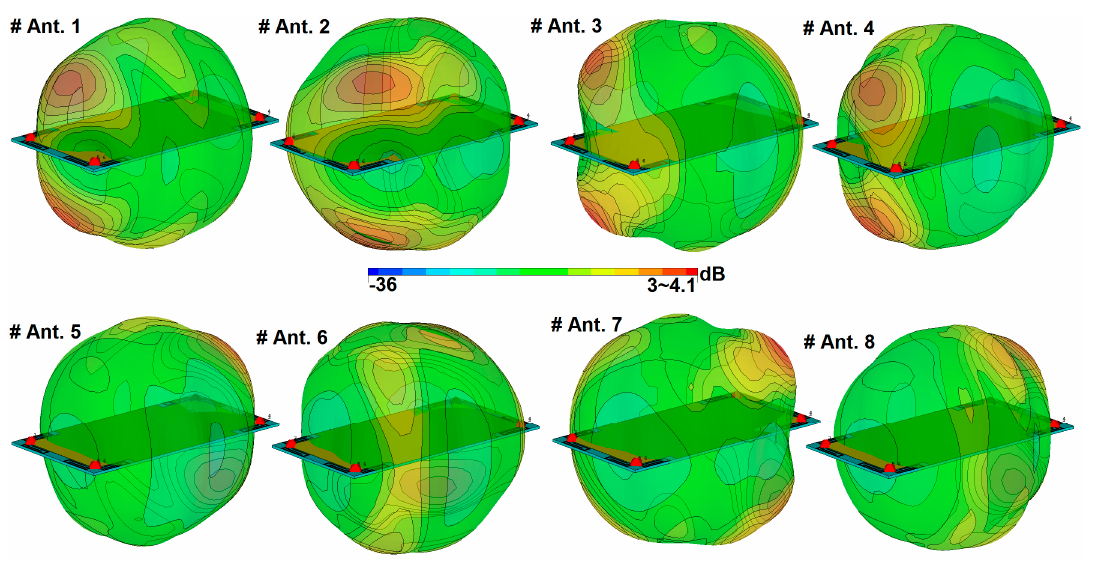
Figure 7. Side views of the antenna radiation patterns at ( a ) first (2.6 GHz), ( b ) second (3.6 GHz), and ( c ) third (5.8 GHz) resonances.